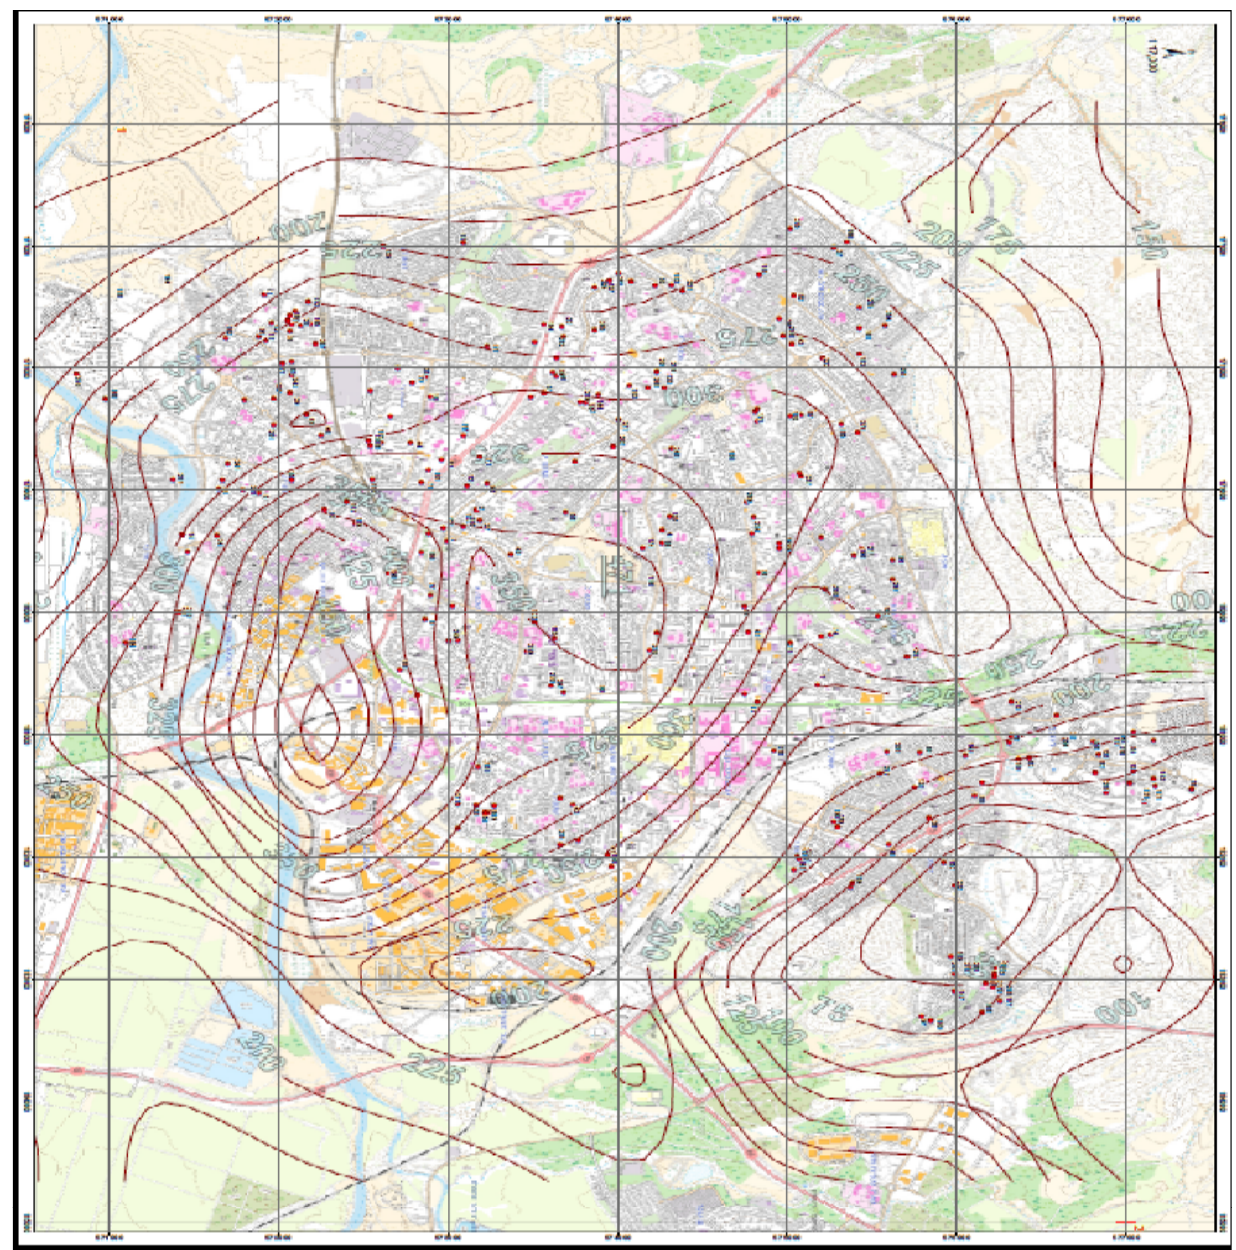
Figure 1. Half ‐ hour average concentration of nitrogen oxides in Beer Sheva calculated by AIRMOD pollutant dispersion model with the addresses of the women (red